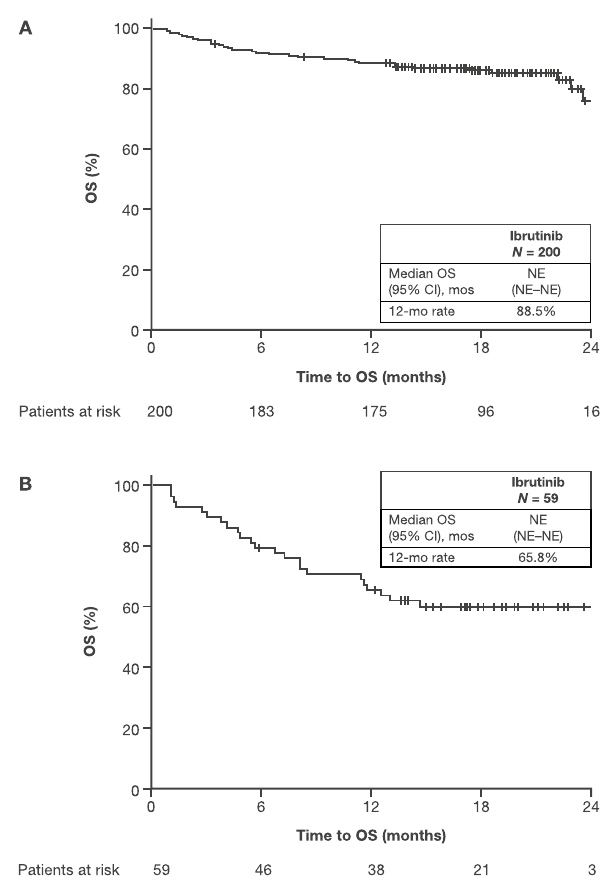
Fig. 2 Impact of ibrutinib on OS in patients with CLL/SLL ( A ) and patients with MCL ( B ). CI confidence interval; CLL chronic lympho- cytic leukemia; MCL mantle cell lymphoma; mo month, NE not esti- mable; OS overall survival; SLL small lymphocytic